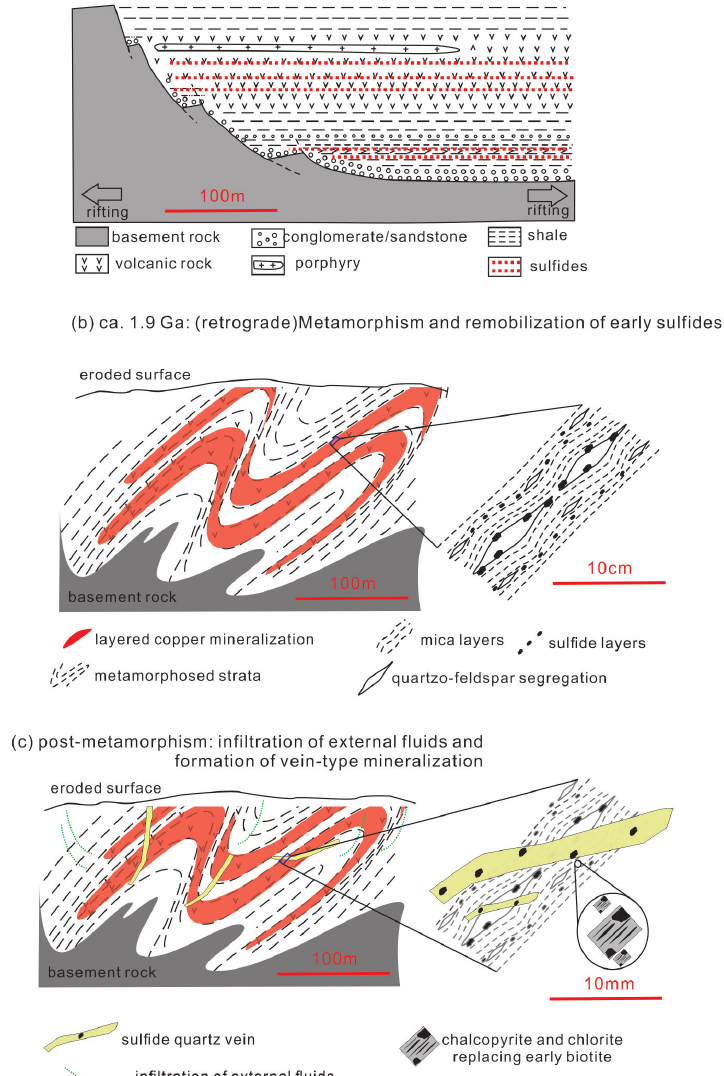
Figure 13. ( a ) A genetic model illustrating the formation of stratabound sulfide mineralizations during the development of a rift basin in the Tongkuangyu copper deposit at ca.2.2 to 2.1 Ga; ( b ) post to the peak metamorphism at ca.1.9 Ga, the precursor sulfides were remobilized by retrograde metamorphic fluids that generated by mineral breakup, and formed the layered mineralization and related mineral assemblage; and ( c ) with the further exhumation of the terrane, external fluids infiltrated into the metamorphic-hydrothermal system and formed quartz veins with a decreased oxygen fugacity and reduction reaction with early